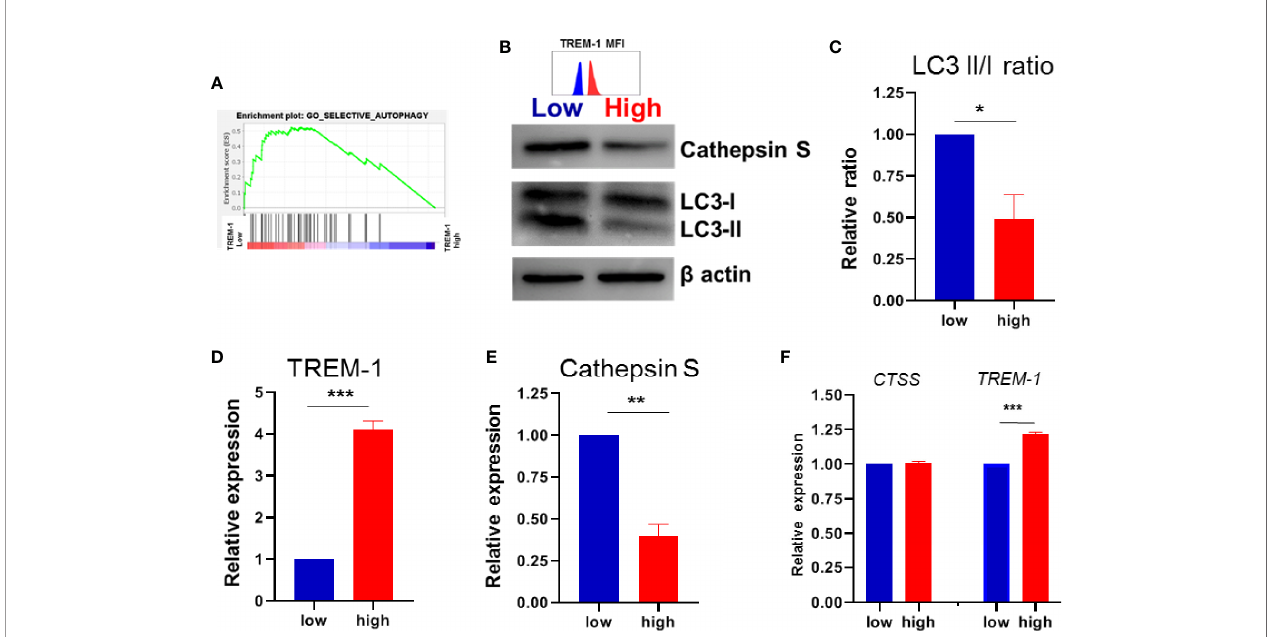
FIGURE 3 | TREM-1 expression and autophagy. (A) GSEA plot of autophagy in low versus high TREM-1 CD14+ monocytes. (B) Immunoblot for LC3I and LC3II, Cathepsin S and b-actin as a loading control in paired low vs high TREM-1 CD14+ monocytes, representative of 4 different donors. TREM-1 MFI of the sorted populations is indicated above the blot The LC3II/I ratio, Cathepsin S and TREM-1 expression (MFI) were quanti fi ed in (C – E) and expressed relative to the low TREM-1 population. (F) CTSS gene and TREM-1 expression from the array. Mean + SEM is shown in (C – F) . Signi fi cance was determined paired t-tests (C – E) and Wilcoxon signed rank tests in (F) with *P < 0.05, **P < 0.01, ***P <